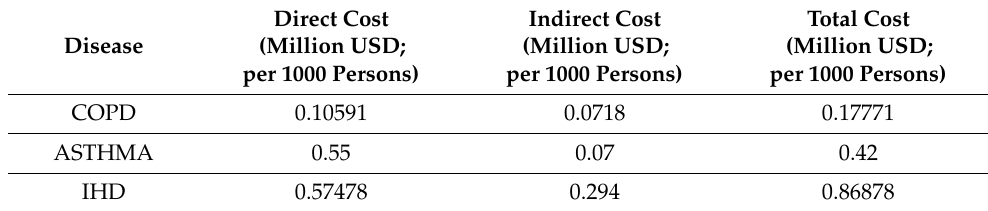
Table 5. Direct and indirect costs of each disease.